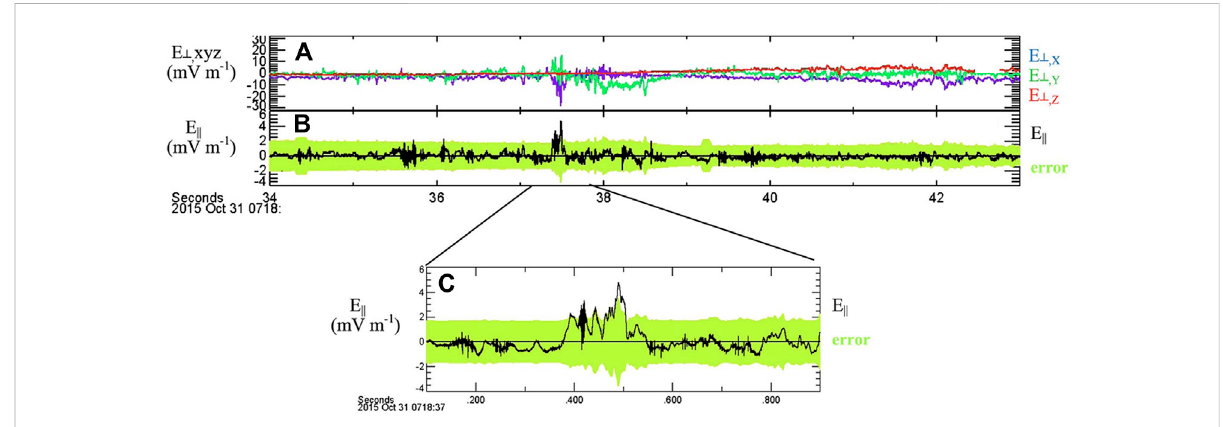
FIGURE 2 MMS (A) perpendicular E- fi eld, (B) parallel E- fi eld (C) zoom-in. The estimated DC uncertainty in the parallel E- fi eld (in green) is usually greater than its measured value. Adapted from (Øieroset et al.,